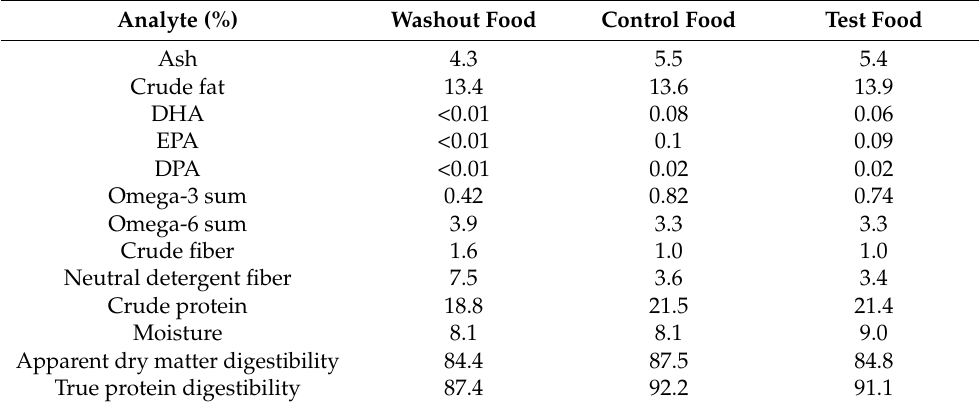
Table 1. Proximate analysis of foods used in this study.